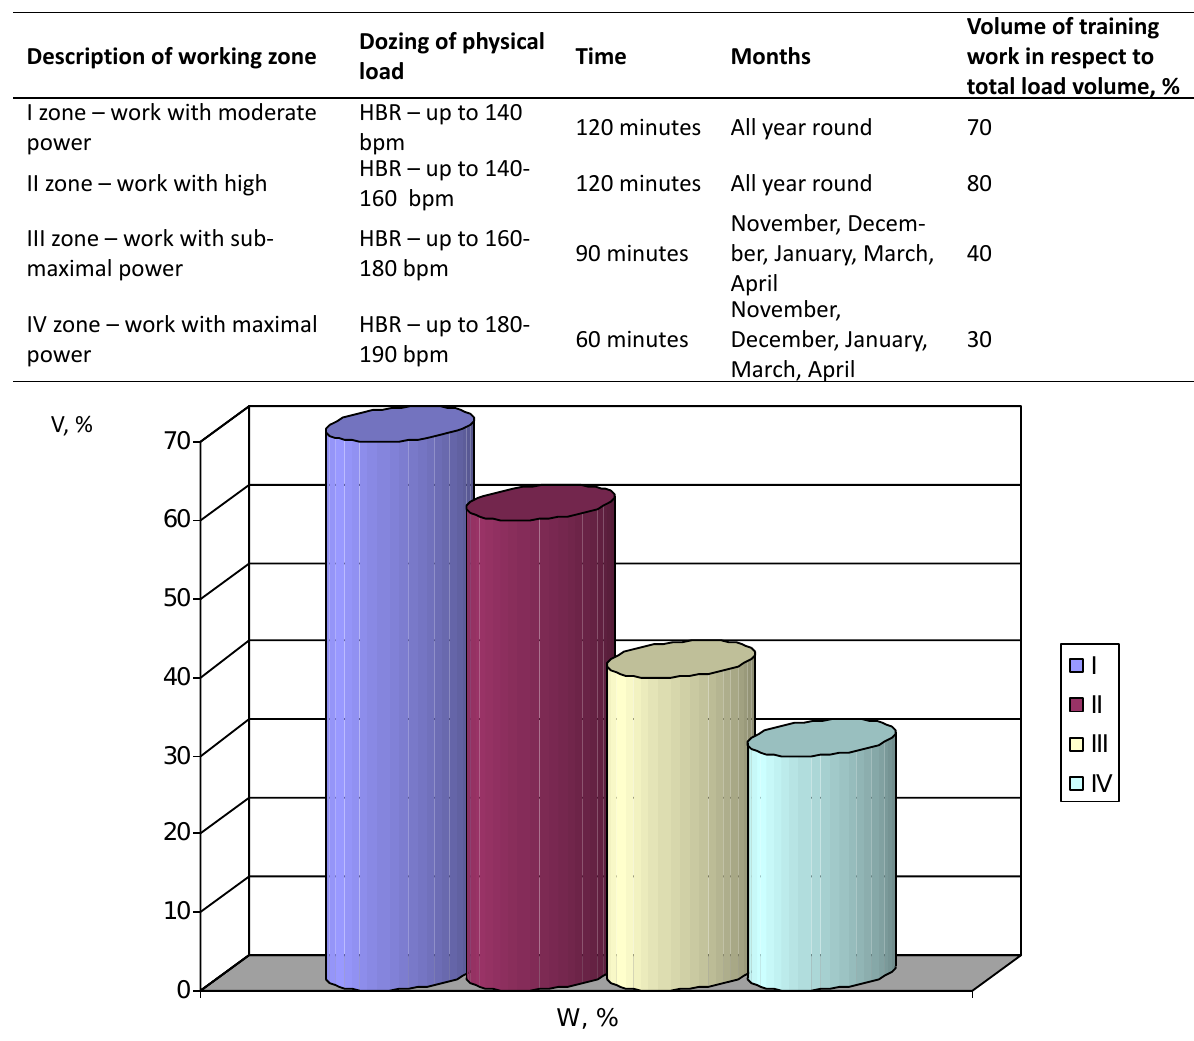
Table 2. Distribution of cyclic exercises in annual plan of middle distance light athletes’ training Description of working zone